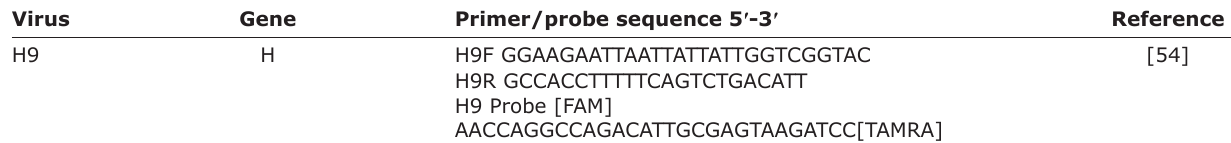
Table-3: Oligonucleotide primers and probes used in real-time PCR.